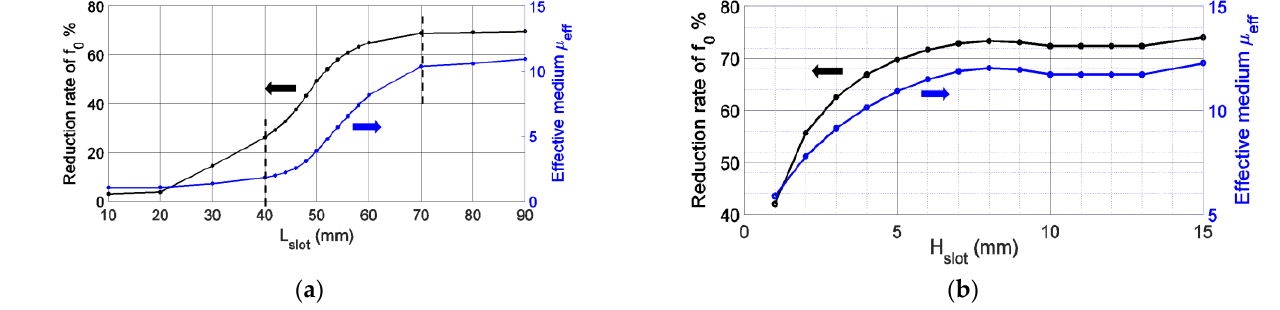
Figure 9. ( a ) Reduction rate of f 0 and μ eff in function of the slot ’ s length L slot . ( b ) Reduction rate of f 0 and μ eff in function of the slot ’ s height H slot .